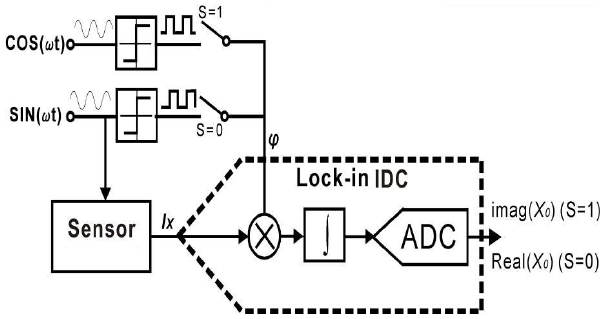
Figure 14. The structure of the lock-in Σ∆ impedance extraction circuit. The circuit extracts the imaginary portion of admittance when S = 1 and the real portion when S = 0 (adapted from [16]).